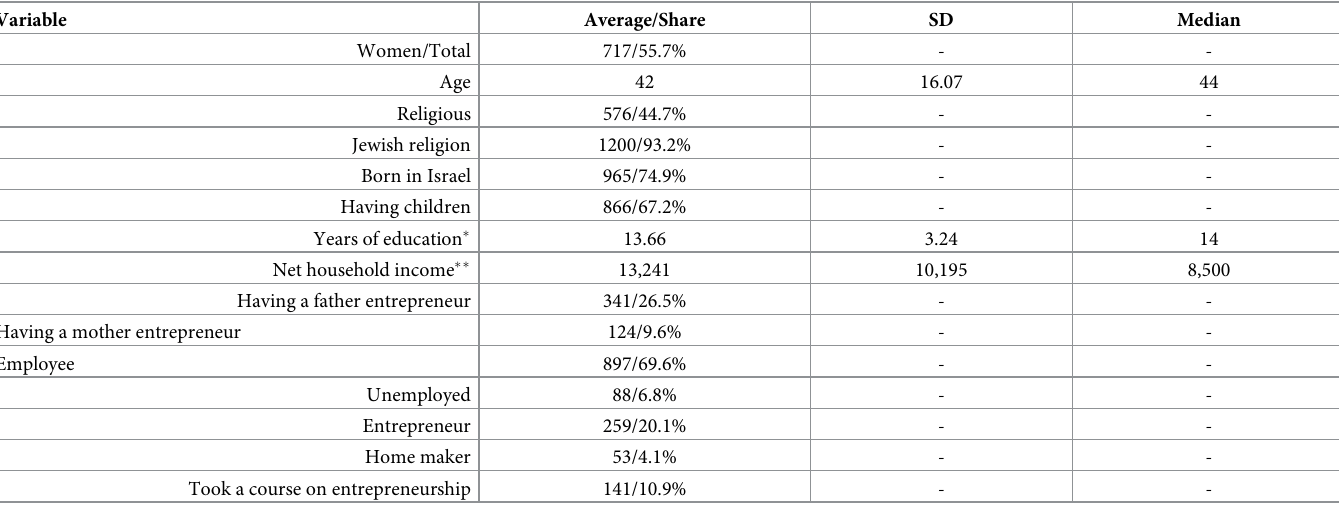
Table 1. Summary